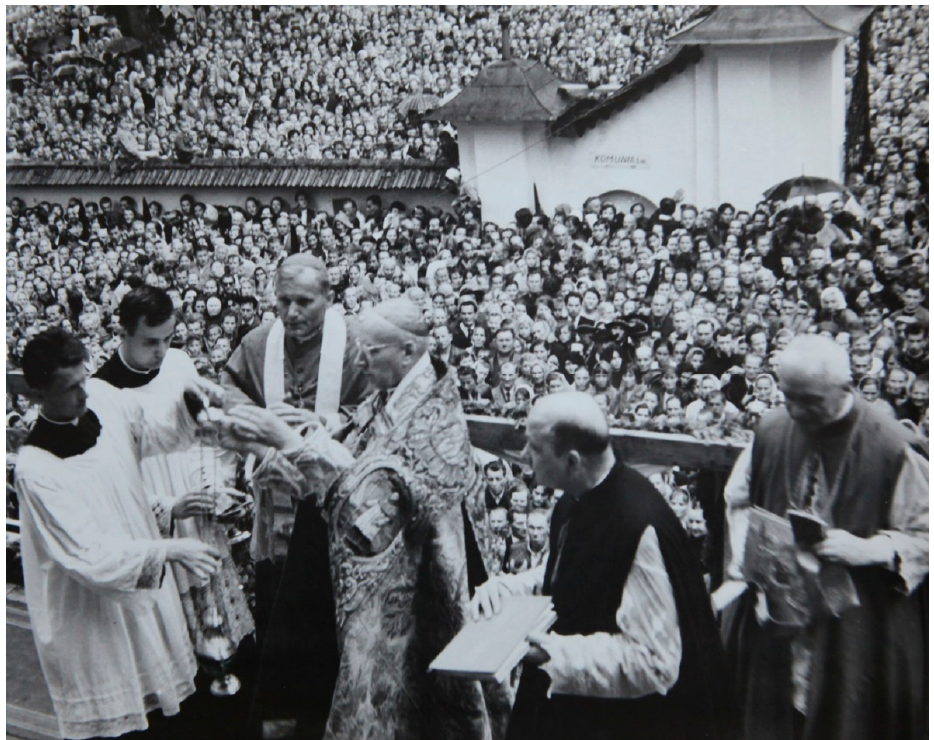
Figure 6. Celebrations of the coronation of the image of Our Lady of Rychwa ł d in Rychwa ł d (18 July 1966) (photo: Archives of the Sanctuary of Our Lady of Rychwa ł d in Rychwa ł d).